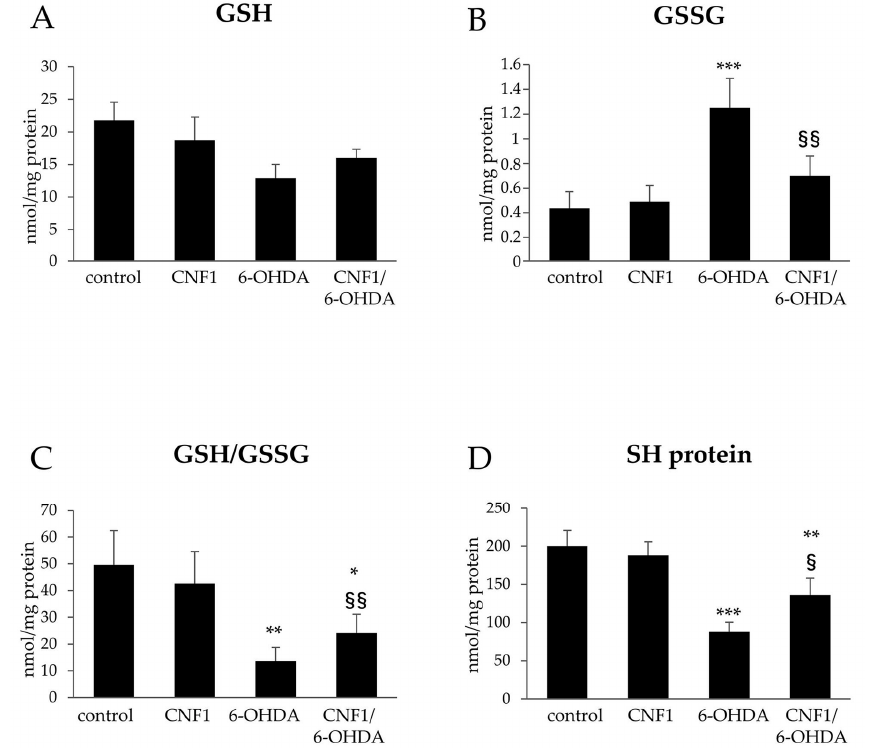
Figure 4. Evaluation of reduced glutathione (GSH), oxidized glutathione (GSSG) and SH protein sulfhydryl group in SH-SY5Y cells. ( A ) GSH; ( B ) GSSG; ( C ) GSH / GSSG ratio; ( D ) SH protein sulfhydryl group. The results are expressed as mean ± SEM from four independent experiments. * p < 0.05, ** p < 0.01, and *** p < 0.001 compared with control; § p < 0.05 and §§ p < 0.01 compared with